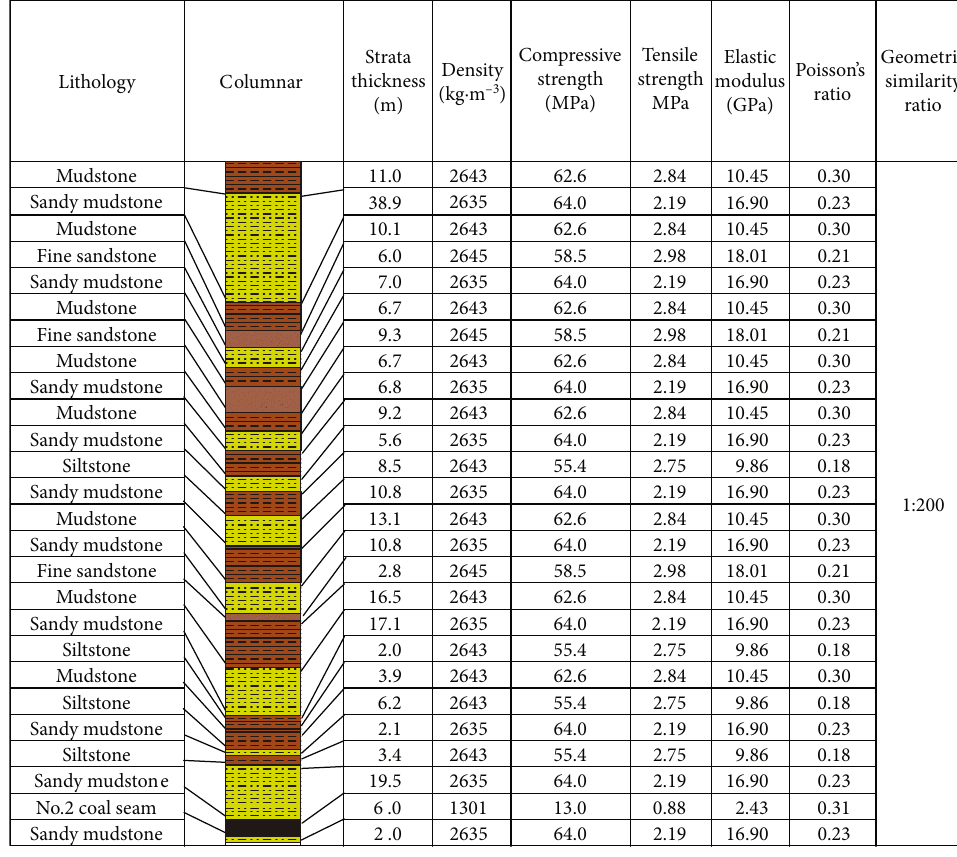
Figure 2: Mechanical parameters of overlying strata in the No. 2 coal seam.